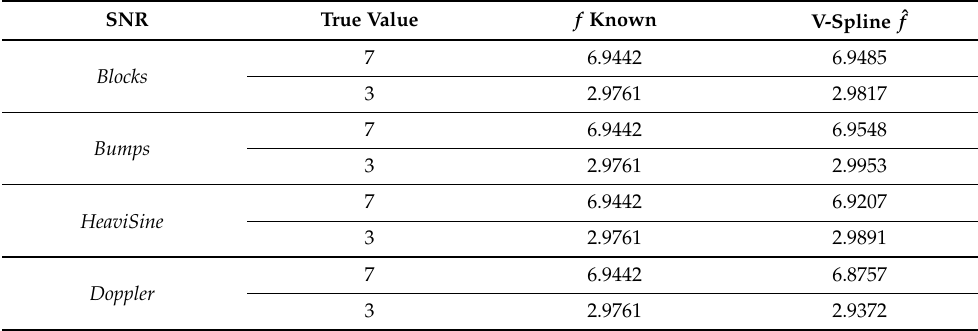
Table 3. Retrieved SNR by adaptive